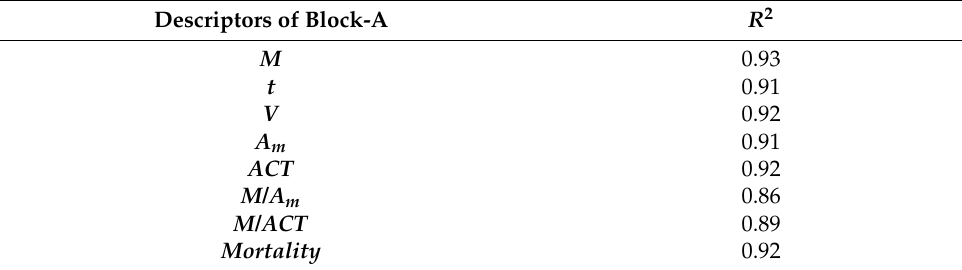
Table 1. Regression studies of Block A and mortality with Block B.